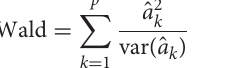
thousand-grain weight (GW), filled grain number per panicle (GN), grain weight per plant (GY), and spikelet number per panicle (SN). HD was recorded when the panicle was exerted ∼ 50% of the plants in a